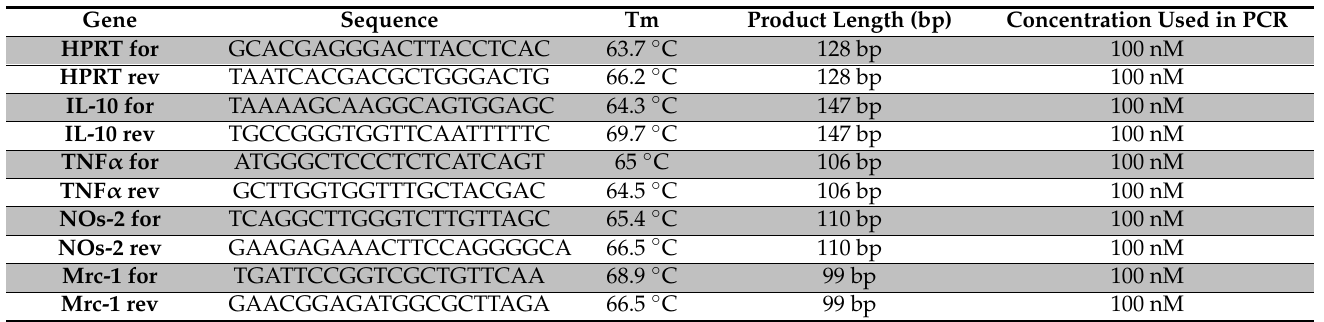
Table 1. Rat specific primer combinations for quantitative real time